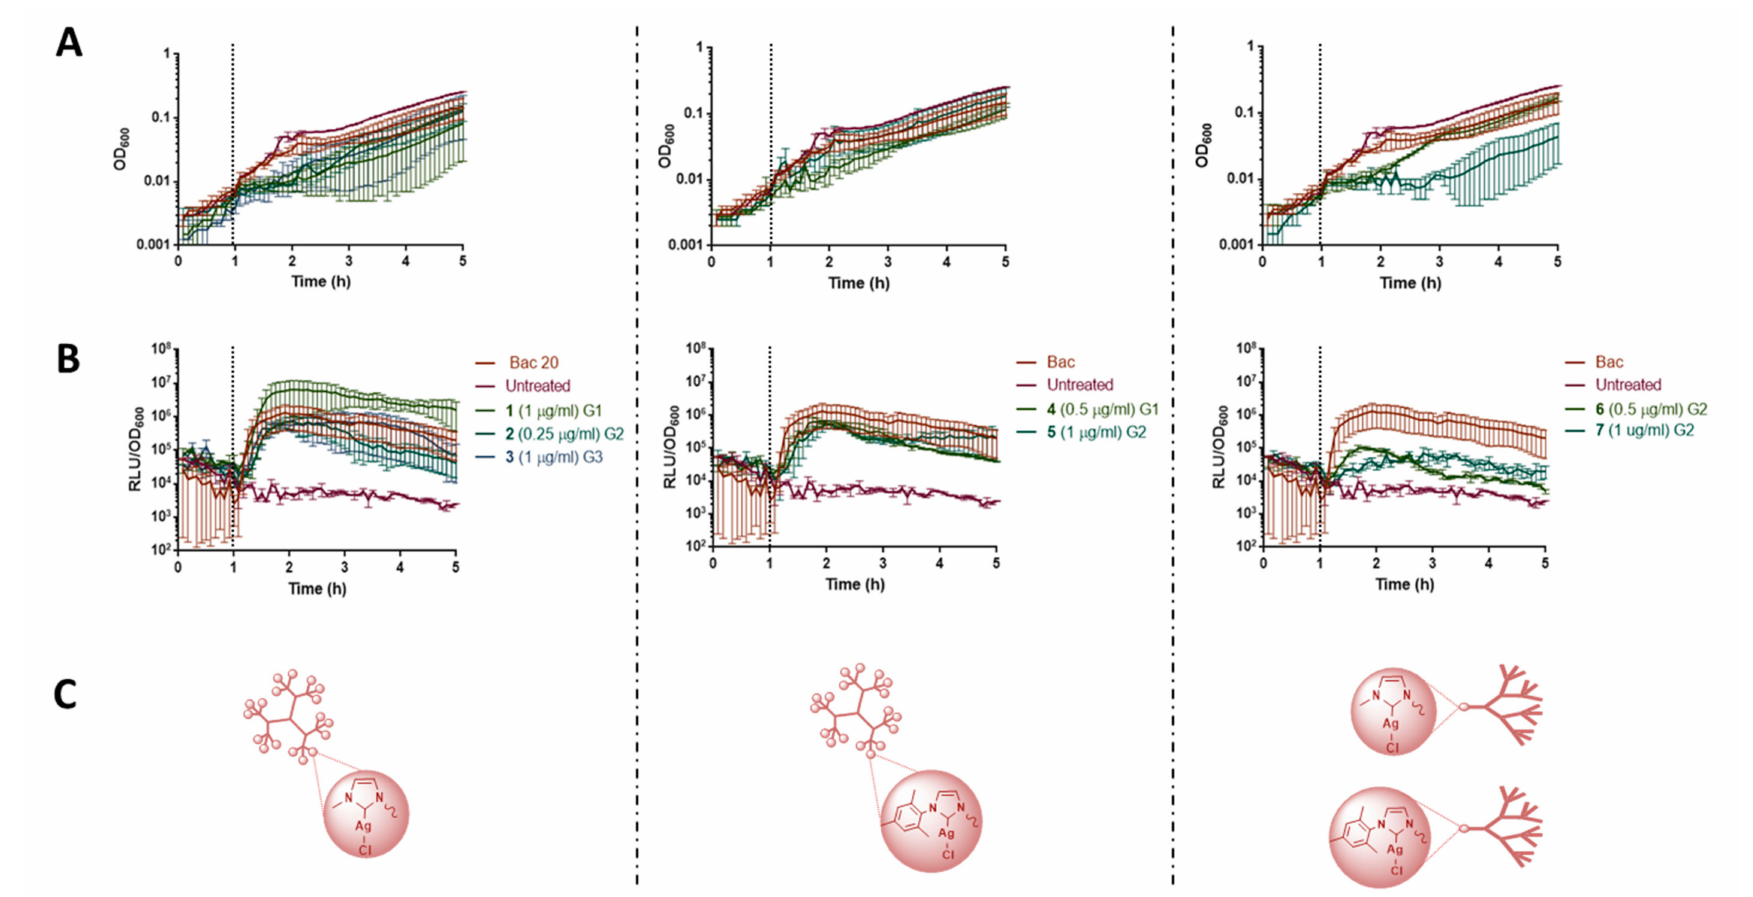
Figure 1. P liaI biosensors response in the presence of dendritic systems containing Ag(I)-NHC. ( A ) OD 600 values; ( B ) relation between luminescence / OD 600 ; ( C ) Schematic representation of compounds. Dash lines in graphs A and B at 1 h denote the addition of